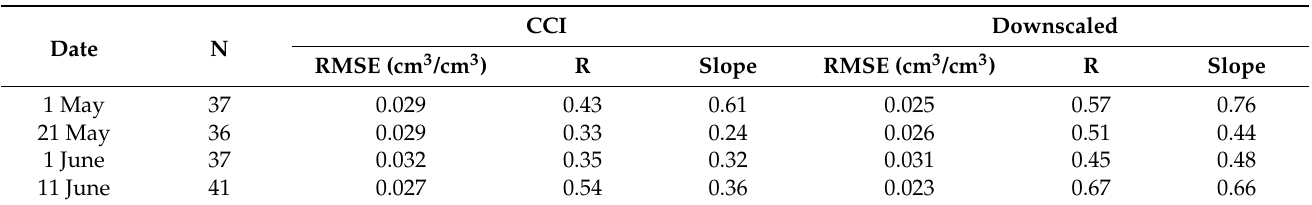
Table 2. Statistical comparisons of RMSE, correlation coefficient, and slope indicators between the